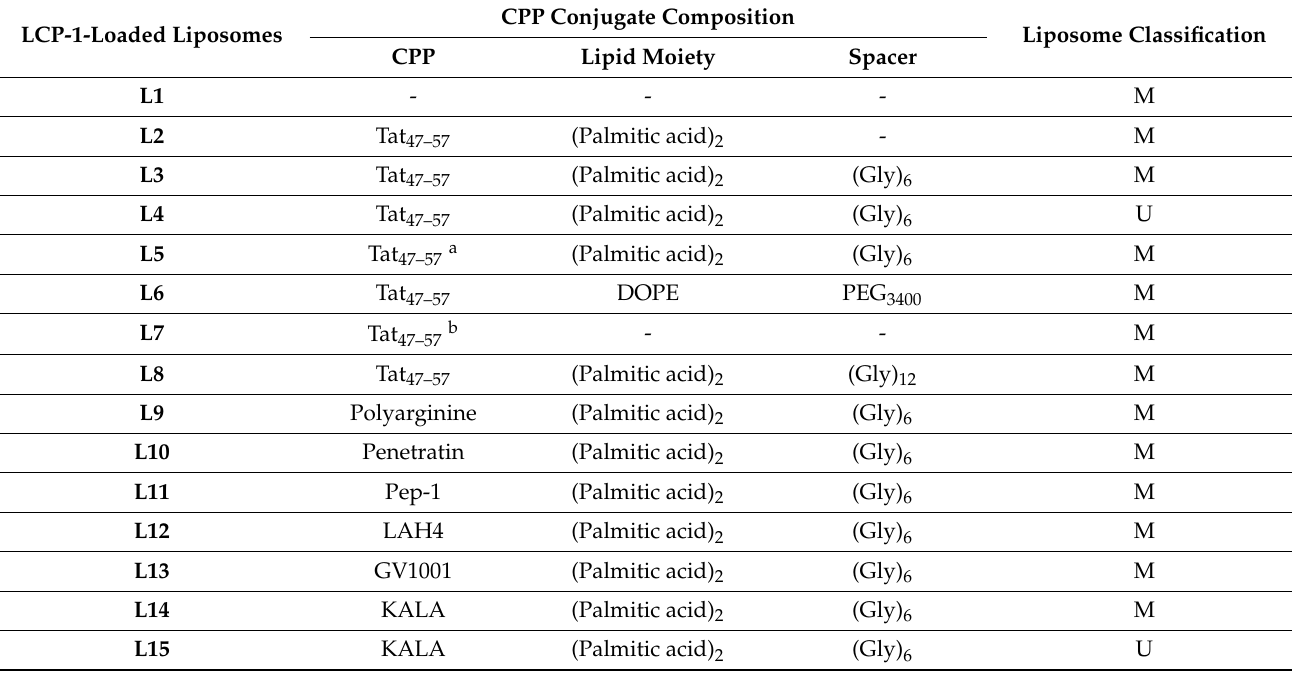
Table 2. Composition of CPP conjugates comprised in LCP-1 loaded liposomes ( L1 – L15 ). LCP-1-Loaded